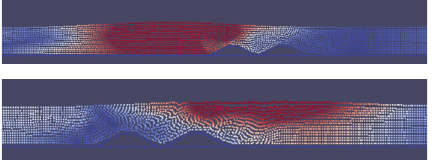
Figure 19: Particle representation of SPH